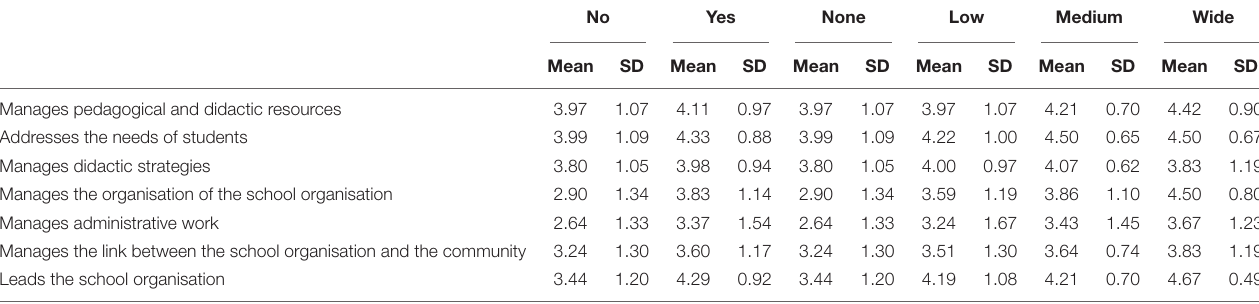
TABLE 3 | Descriptive statistics (Mean and SD) by dimensions based on managerial experience.